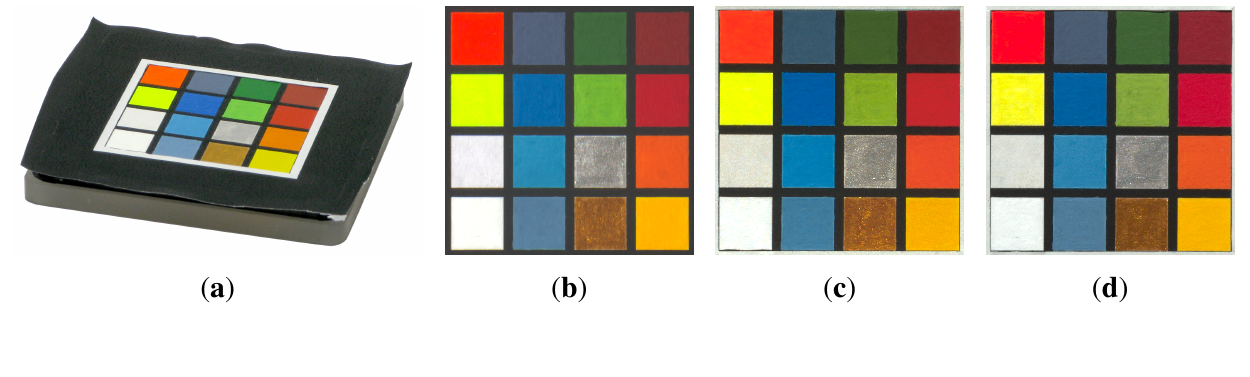
Figure 3. A handmade material chart (a), used for comparing the accuracy of our three setups. Fields column-wise: Fluorescent Red, Fluorescent Yellow, Paper, White, Blue3, Blue2, Blue1, Turquoise, Green2, Green1, Silver, Gold, Red2, Red1, Orange, Yellow. (b)–(d) show rectified and radiometrically corrected measurement images ( θ i = 45 ◦ , φ = 0 ◦ , θ = 0 ◦ , φ = 0 ◦ ) from each of our three setups. For illustration purposes, the i o o result images are tonemapped and converted to sRGB colorspace. ( a ) overview